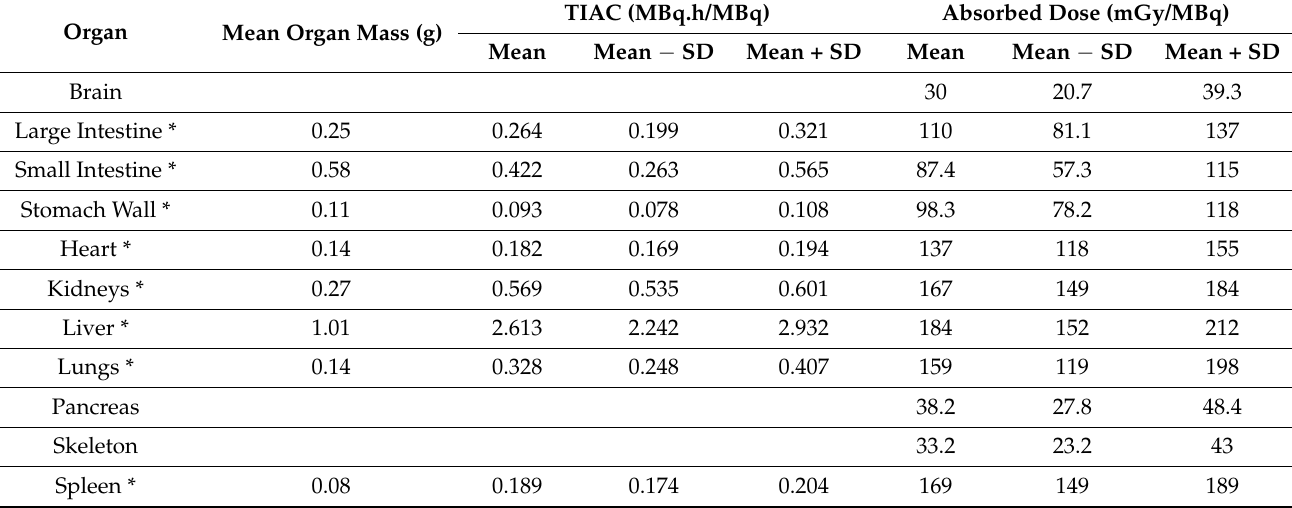
Table 3. Measured average organ masses and TIAC (only for source organs) and estimated organ doses obtained with the OLINDA/EXM 2.1 software for [ 64 Cu]Cu-1C1m-Fc. Source organs are indicated with *. Absorbed dose estimates using the sphere model of the OLINDA/EXM 2.1 software are labeled with s . The normalized time–activity curves for the considered source organs are presented in the Supplementary Materials (Figure